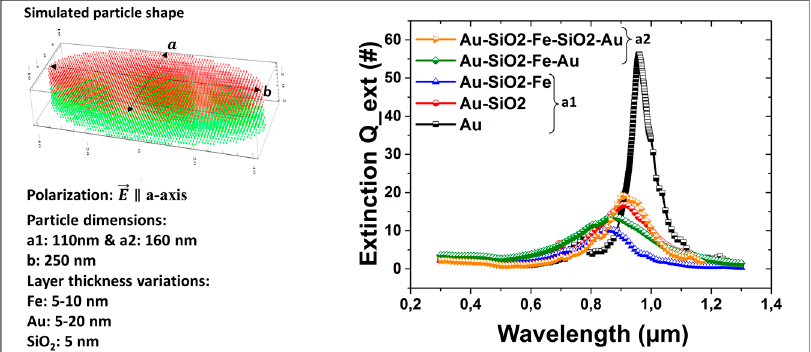
Figure 3. Simulated extinction factor Q _ext for varying geometry and material composition for light polarization parallel to the particles